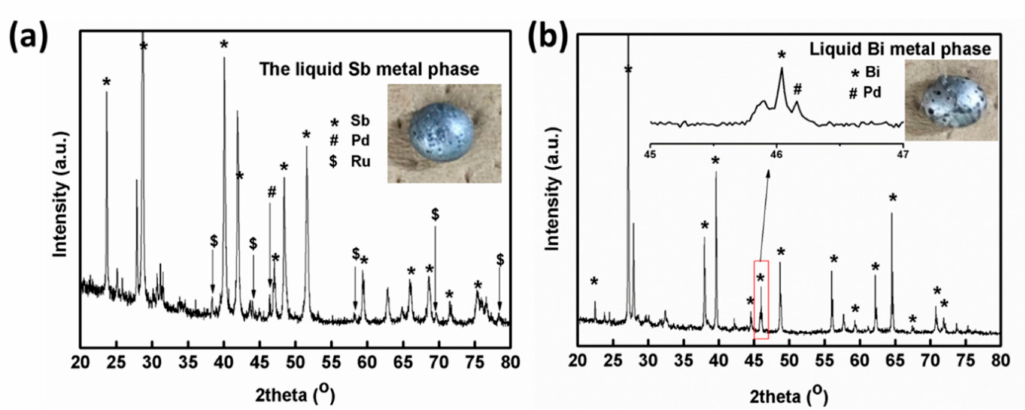
Figure 1. XRD patterns and the pictures (inset) of ( a ) the reduced Sb metal from the batch 1 and ( b ) the reduced Bi metal from the batch 2 after heat treatment under reducing